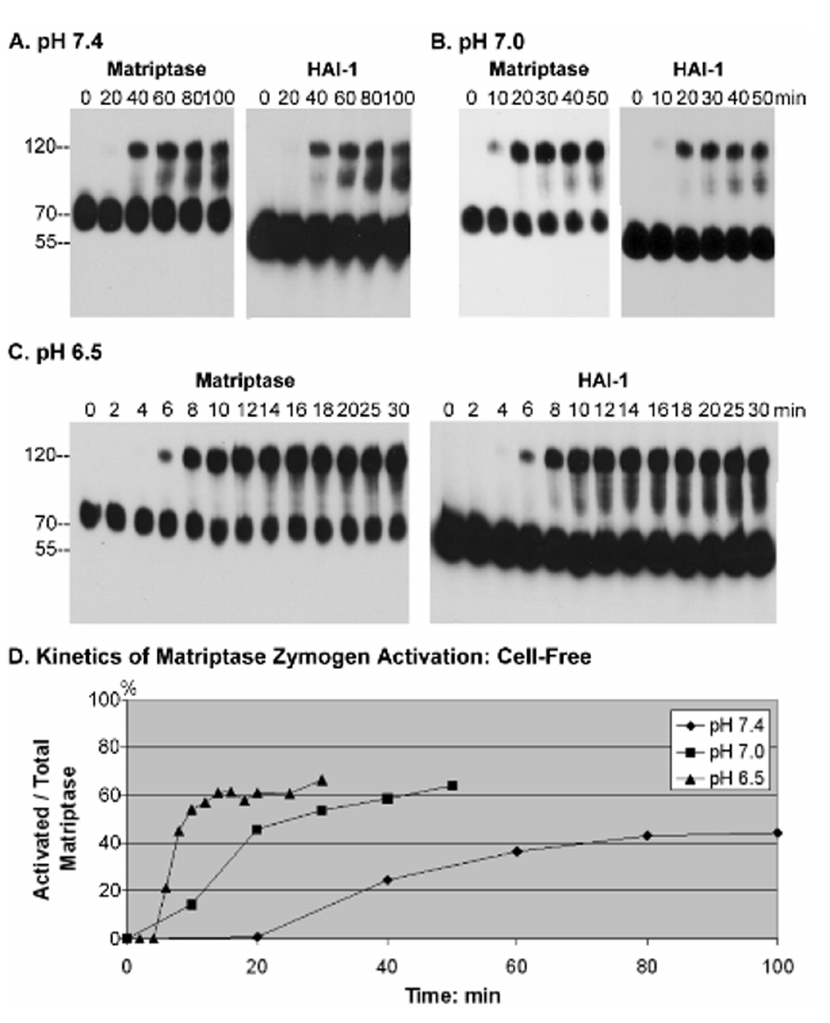
Figure 1. Time and pH-dependence of matriptase zymogen autoactivation in cell-free setting. The insoluble fractions of cell homogenates prepared from 184 A1N4 mammary epithelial cells were exposed to phosphate buffers at pH 7.4 (A), pH 7.0 (B) or pH 6.5 (C) at room temperature for the indicated time. Lysates were prepared and assayed by immunoblot analyses for matriptase with mAb M24 (which recognizes the 70-kDa matriptase zymogen and 120-kDa activated matriptase-HAI-1 complex) or for HAI-1 with mAb M19 (which recognizes the 55-kDa HAI-1 and 120-kDa activated matriptase-HAI-1 complex). Note that both antibodies also recognize degraded forms of the activated matriptase-HAI-1 complex. (D) Kinetics for induction of matriptase activation in cell-free homogenates. Representative data showing the ratio of activated matriptase relative to total matriptase (activated plus zymogen matriptase) for each pH plotted against time using Image J.